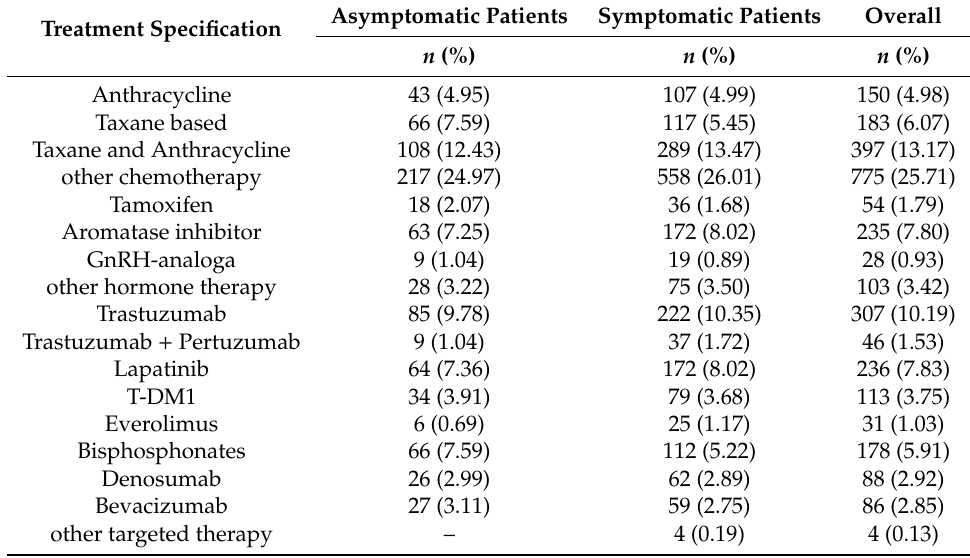
Table 3. Breast cancer treatment after BM diagnosis (systemic treatment, endocrine therapy, targeted therapy) for patients with and without neurological symptoms.